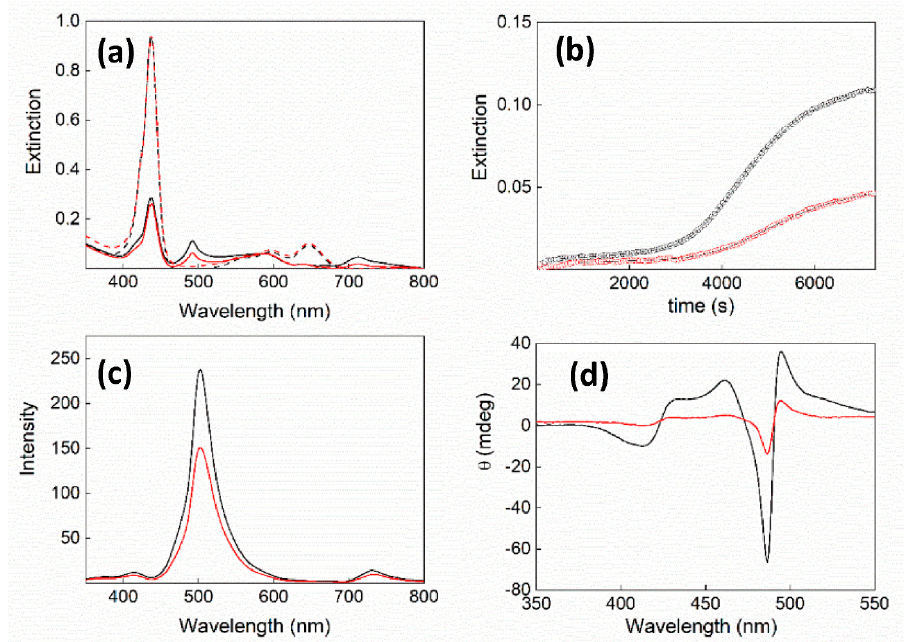
Figure 6. ( a ) Extinction spectra soon after initial mixing (dashed lines) and at the end of the aggregation (solid lines), ( b ) kinetic extinction time traces at λ = 492 nm (solid lines show the best fit of the experimental data according to Equation (1)), ( c ) RLS, and ( d ) CD spectra for the supramolecular assembling of H 2 TPPS 44- induced by salt and tartrate buffer (L: black lines; D: red lines) using mix 3 protocol. Experimental conditions: [H 2 TPPS 44- ] = 3 μ M; [NaCl] = 1.5 M; tartrate buffer 100 mM, pH 2.7, T = 298 K.